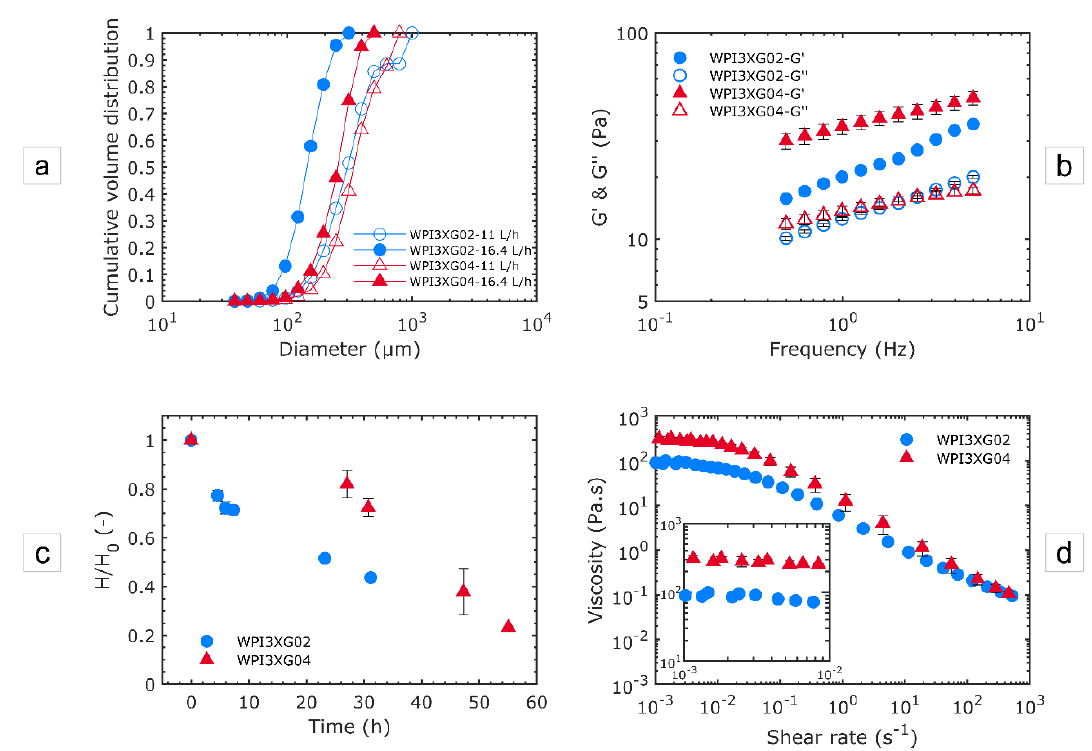
Figure 10. Effect of xanthan gum concentration on the structural and usage properties of foams produced with the device CX-E-600 and the model solutions WPI3XG04 and WPI3XG02. Circles stand for WPI3XG02 and triangles for WPI3XG04. Empty symbols stand for 11 L · h − 1 and full symbols for 16.4 L · h − 1 . ( a ) Bubble size distributions in the foam in cumulative volume at two flowrate conditions: Q vL = 11 L · h − 1 − Q mG = 21.6 g · h − 1 and Q vL = 16.4 L · h − 1 − Q mG = 31 g · h − 1 . The diameters of bubbles inside the microchannels are normalized to the atmospheric pressure. ( b ) Mechanical moduli of foams at 20 ◦ C for Q vL = 11 L · h − 1 − Q mG = 21.6 g · h − 1 . ( c ) Stability of foams for Q vL = 11 L · h − 1 − Q mG = 21.6 g · h − 1 . ( d ) Viscosity characterization of foams at 20 ◦ C for Q vL = 11 L · h − 1 − Q mG = 21.6 g · h − 1 .